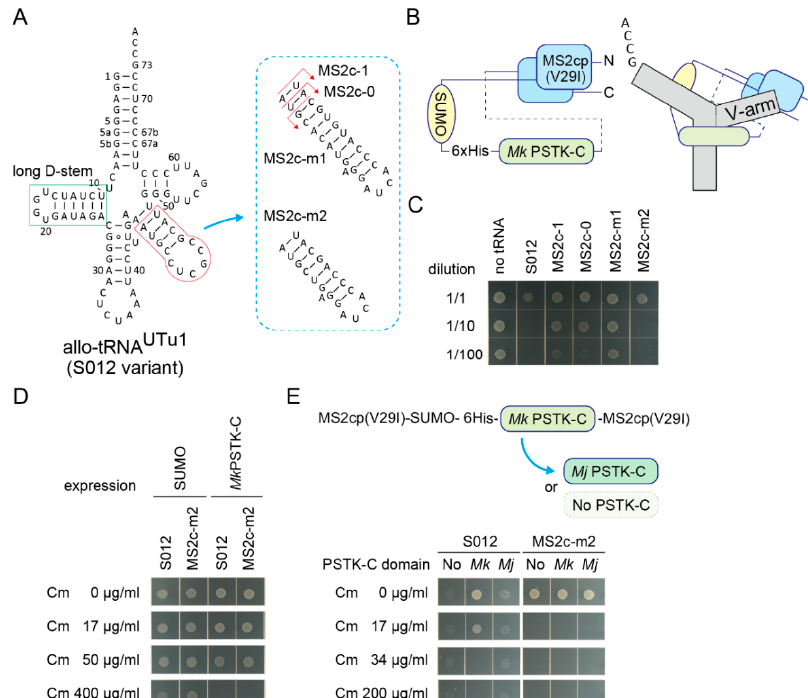
Figure 4. Sequestration of fully active allo-tRNA Ser molecules. ( A ) The cloverleaf structure of S012 tRNA variants having a MS2 hairpin C -loop variant with varying lengths of adaptors. The long D-stem of S012 variants is tightly bound by the C -terminal domain of Mk PSTK. ( B ) A structural model of the fusion protein consisting of an MS2 coat protein V29I variant monomer, a SUMO tag, a 6xHis tag, a Mk PSTK-C, and another V29I monomer. The N -terminus and C -terminus are indicated. A binding model of a S012 variant and this fusion protein is shown, too. ( C ) The S012 and MS2c-m2 variants most efficiently impaired the growth of E. coli DH10B cells expressing the cat(Ser146TAG) reporter gene and the SUMO protein. Cell cultures were diluted (10 times and 100 times) or non-diluted and spotted on an agar plate. The arabinose concentration was raised to 0.1% from 0.01% to observe clear differences. ( D ) The Mk PSTK-C protein not fused with the MS2 coat protein failed to fully sequester both S012 and MS2c-m2 molecules in E. coli DH10B cells expressing the cat(Ser146TAG) . ( E ) The Mk PSTK-C domain of the chimeric fusion protein was replaced with an Mj PSTK-C domain or simply removed. All fusion protein variants perfectly sequestered MS2c-m2 molecules in E. coli DH10B cells expressing the cat(Ser146TAG) , indicating that the single-chain coat protein moiety tightly bound with the MS2 hairpin moiety of MS2c-m2. On the other hand, S012 molecules were sequestered only by the Mk PSTK-C-containing fusion protein. The other fusion proteins failed to repress the toxicity and the suppressor tRNA activity of the S012 molecules. Note that cells are unclear but were growing on the Cm-free and Cm-containing agar plates under the S012 + No/Mj conditions.